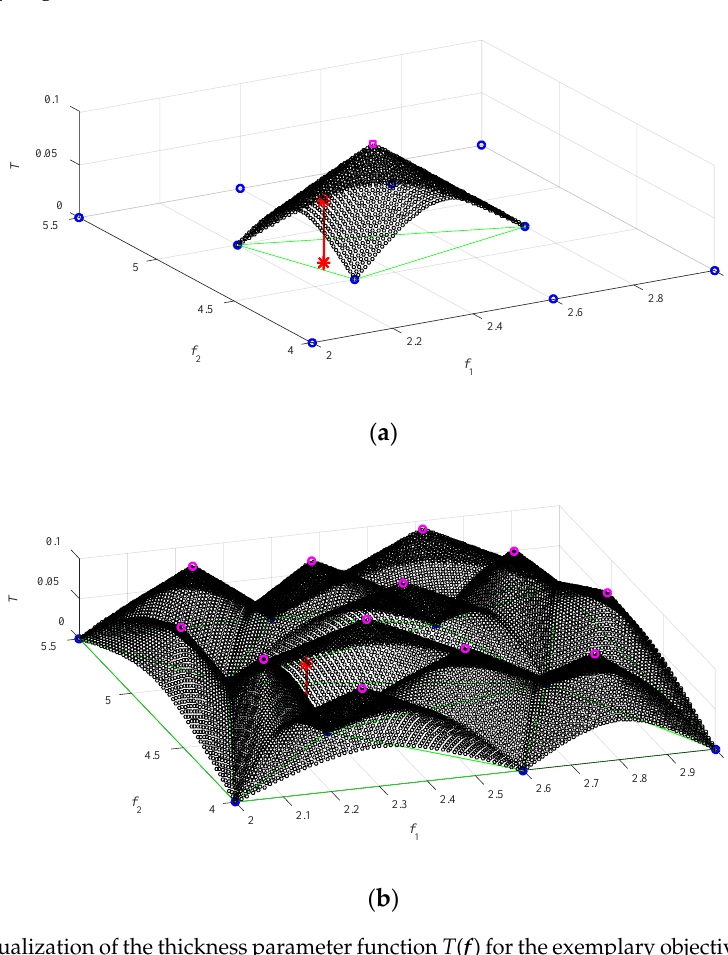
Figure 5. Visualization of the thickness parameter function T ( f ) for the exemplary objective space F : ( a ) a selected simplex and the corresponding thickness function. The vertical line illustrates the thickness value for a particular objective vector marked ∗ ; ( b ) T ( f ) for the entire objective space. The reference objective vectors f ( j ) are shown using circles on the f 1 - f 2 plane; the local maxima of T ( f ) correspond to the simplex centers f T ( j ) .